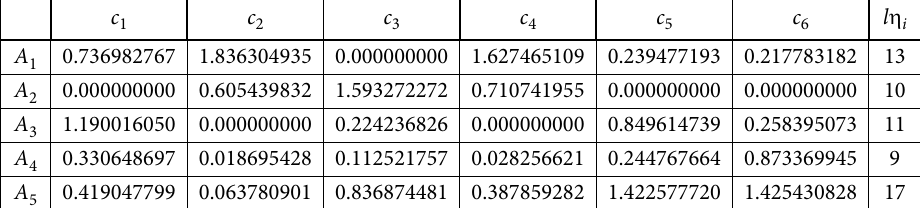
Table 9. The overall lost dominance scores of the alternatives c 1 c 2 c 3 c 4 c 5 c 6 l h i A 1 13